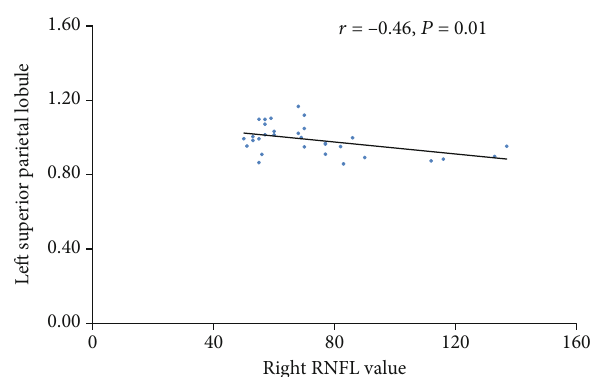
Figure 2: Correlations between right RNFL and the ReHo value of the left superior parietal lobule Abbreviations: REFL: retinal nerve fi ber layer thickness; r : Pearson ’ s correlation coe ffi